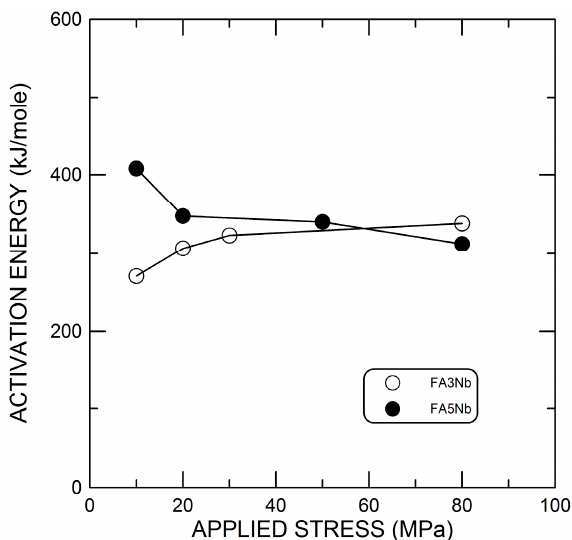
Figure 8. Dependence of activation energy Q on applied stress.